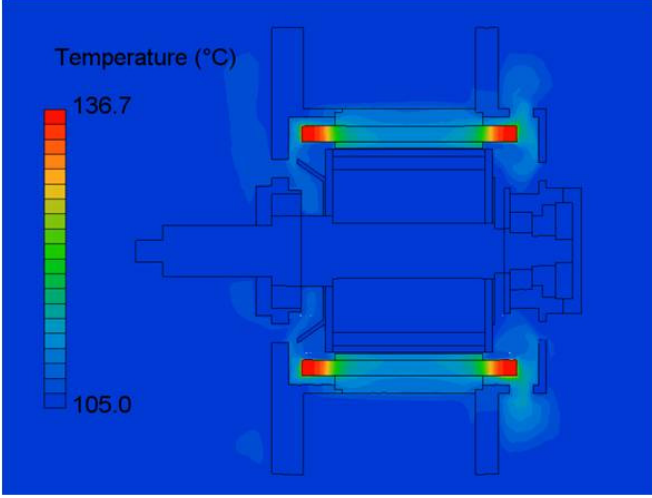
Figure 13. Temperature contours of ISG operating as starter at ambient temperature of 105 